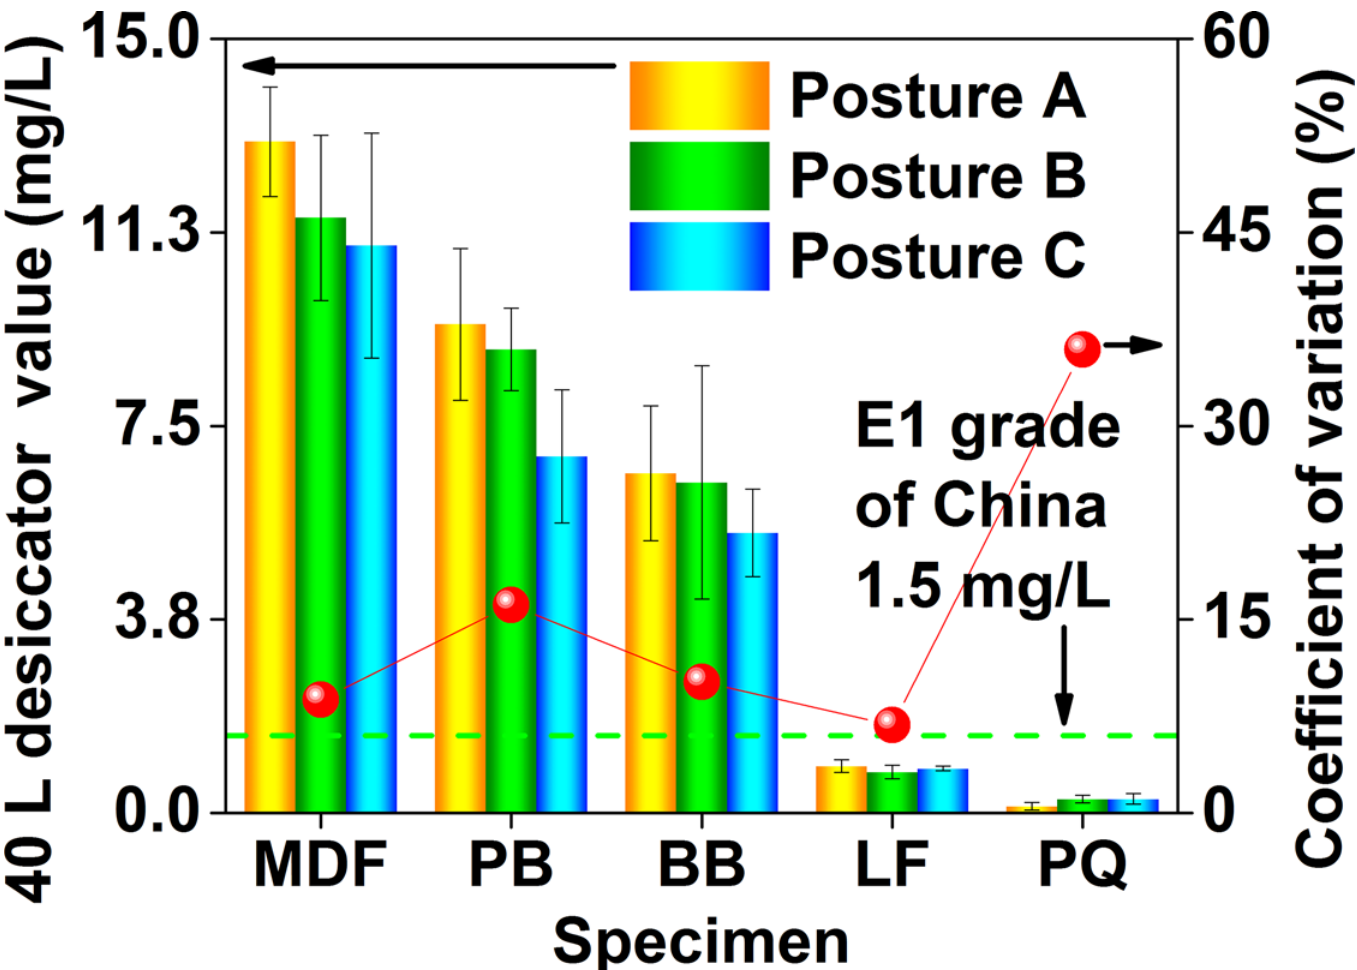
Fig 5. Formaldehyde emission values (40 L desiccator value) of various materials characterized by the 40 L desiccator method (under 3 situations of the specimen placement) of the Chinese national standard GB 18580. MDF, medium density fiberboard; PB, particleboard; BB, blockboard; LF, laminate flooring; PQ, parquet. Posture A, the 450 cm 2 emission surface of the specimen faced the distilled water at the bottom of the desiccator for sampling; Posture B, the 450 cm 2 emission surface of the specimen faced the distilled water with 45°; Posture C, the sealed surface of the specimen faced the distilled water. The coefficient of variation for each material (of the 5 materials) was caused by the formaldehyde emission values derived from the 3 situations of the specimen